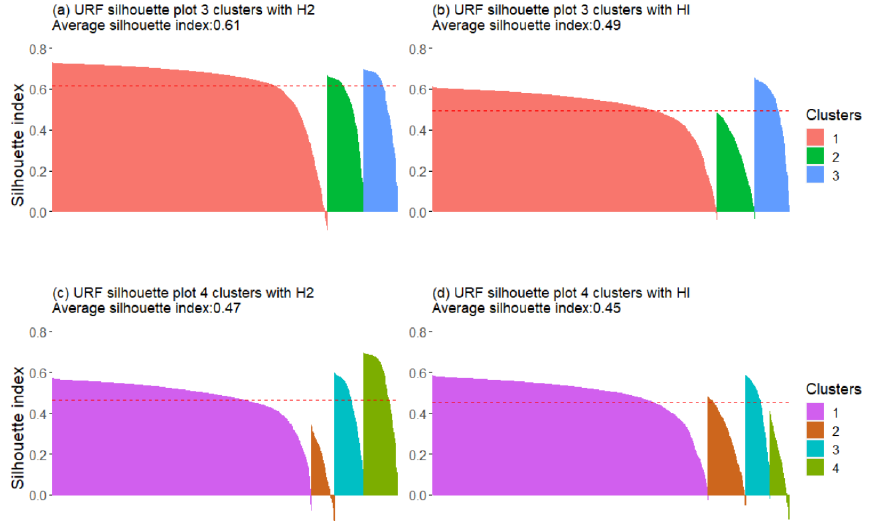
Figure 6. Silhouette plots for the different analyses performed with URF. On the left are those performed with H2, from DFA; the analyses performed with HI, from R/S, are on the right. The top graphics are for three clusters and the bottom graphics are for four. Silhouette plots show the Silhouette Index ( y -axis) for all pixels for each cluster represented on the x -axis.